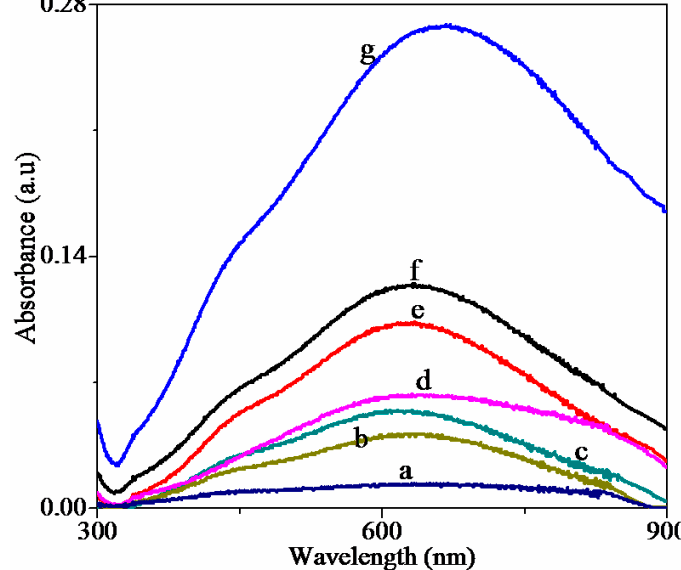
Figure 6. Optical absorbance for silver nanoplate films formed after the various exposure times of ( a ) 15 min, ( b ) 30 min, ( c ) 1 h, ( d ) 2 h, ( e ) 8 h, ( f ) 14 h, and ( g ) 22